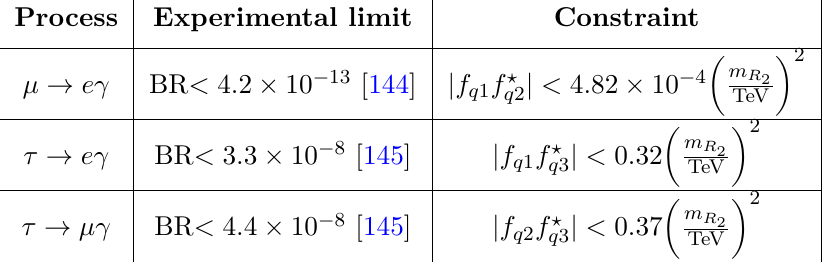
Table 2 . Constraints on the Yukawa couplings as a function of LQ mass from ‘ α → ‘ β γ decay. Constraints on f 0 couplings are obtained by replacing f with ( V ? f 0 ) for the ω 5 / 3 LQ. Constraints on the S 3 Yukawa coupling y ( V ? y ) arising from ¯ d c (6) in comparison to those shown here for the f couplings, suppressed by smaller electric